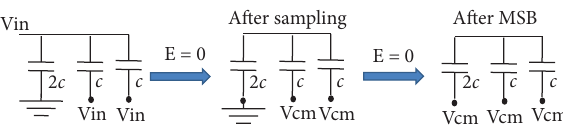
Figure 28: Te charge redistribution